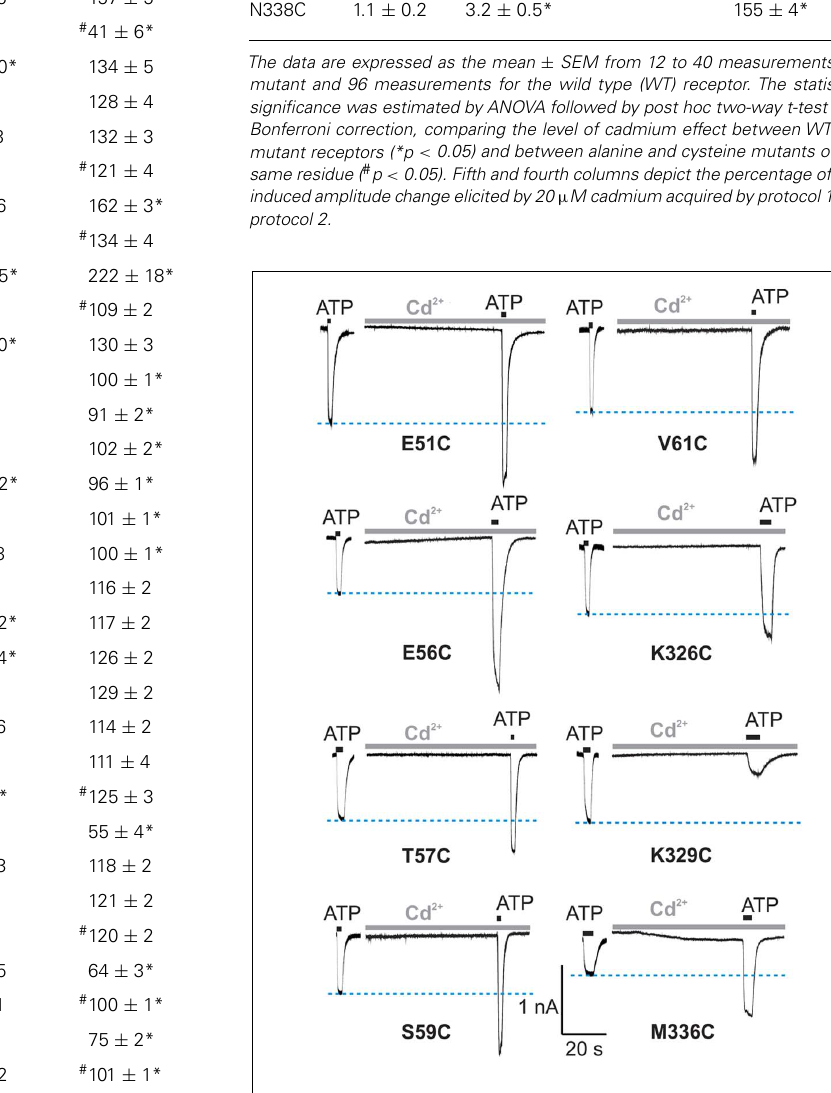
FIGURE 3 | Protocol 1: the effect of cadmium ion pre-application on peak amplitude of current response by mutant rP2X4Rs. The whole-cell current traces represent the effect of 20 μ M cadmium pre-applied for 1 min and subsequently co-applied with EC 50 doses of ATP for 2 s. Horizontal blue lines represent the peak amplitude of currents in cadmium-non-treated cells.Traces shown are representative and mean ± SEM values are shown in Table 1 .The holding potential was − 60